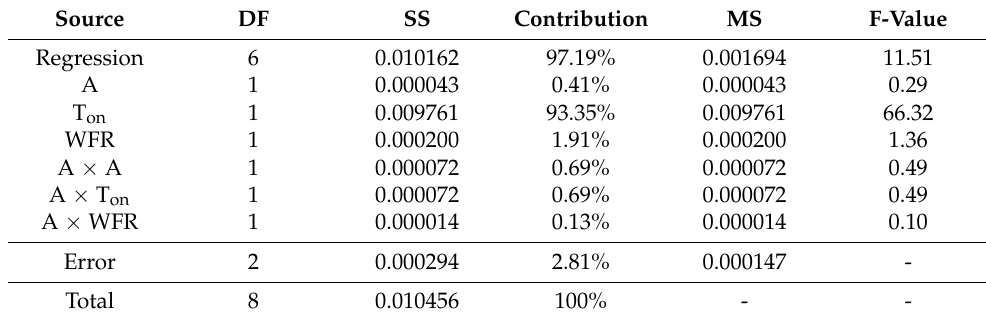
Table 5. Analysis of variance: kerf width—Al6351–5% SiC–5% B 4